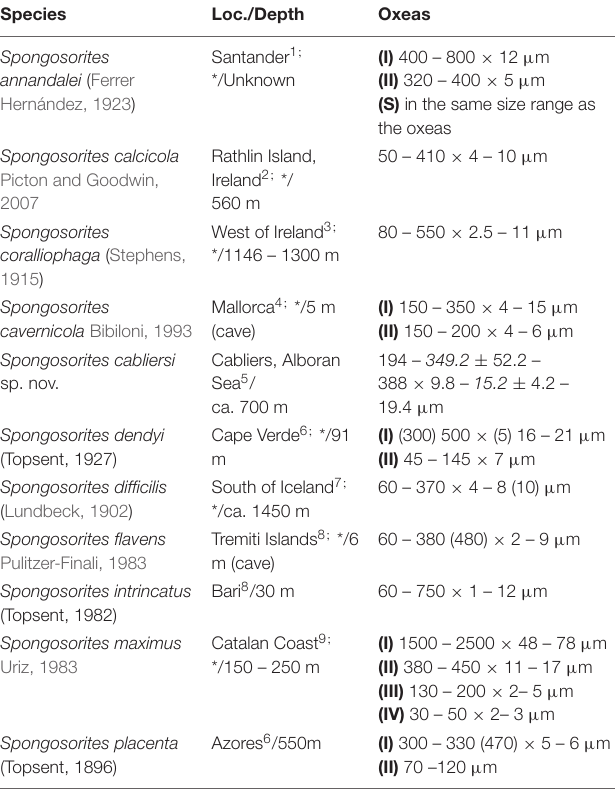
TABLE 6 | Comparative table between the Eastern North Atlantic Spongosorites species, including the locality (Loc.) and depth of the sample, as well as the measurement of their spicular